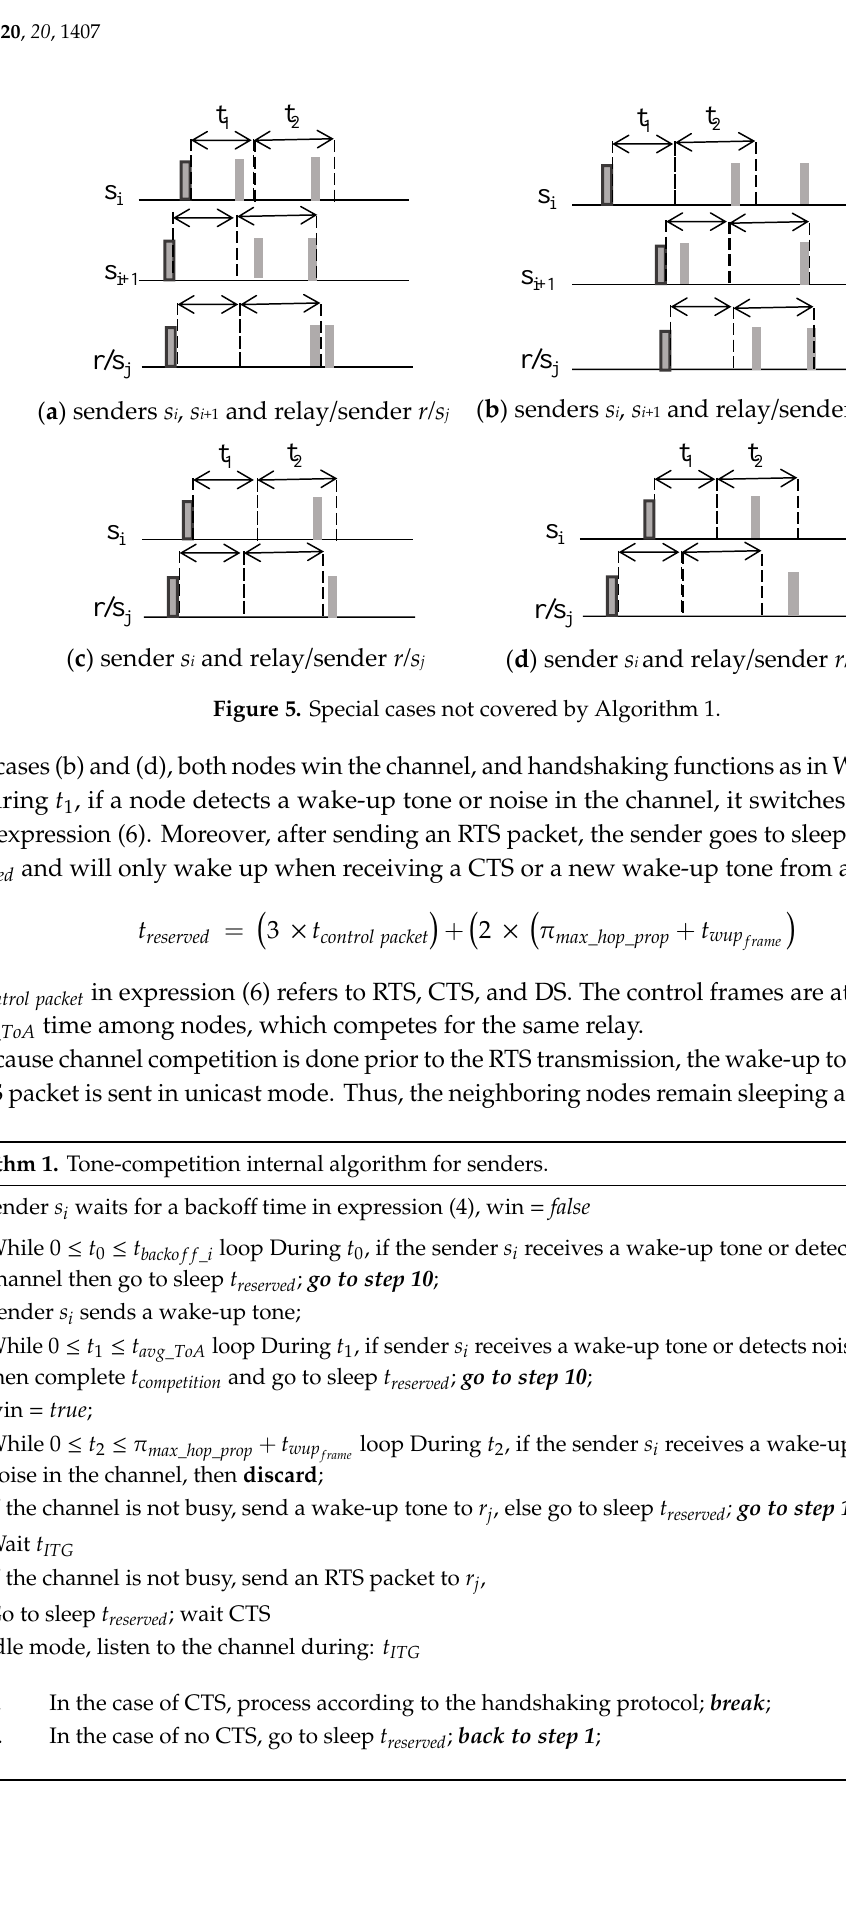
Figure 4. Wake-up reception in two neighboring nodes.